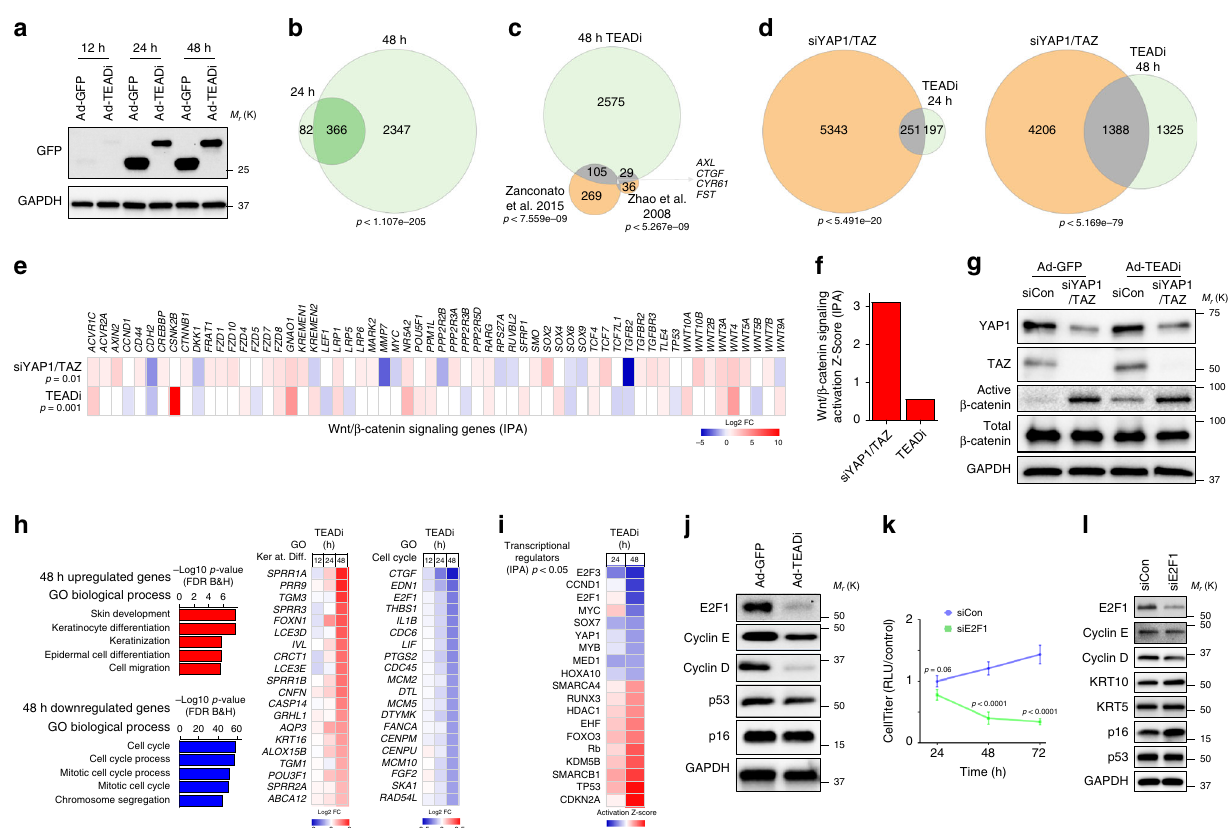
Fig. 2 TEAD transcriptional networks in keratinocytes regulate cell cycle entry and differentiation programs. a Western blot analysis of expression of GFP (Ad-GFP, control) and TEADi (Ad-TEADi) in N/TERT2G cells. b Venn diagram showing the overlap between differentially regulated genes in TEADi vs GFP ( q < 0.05, |FC| ≥ 1.5) in N/TERT2G keratinocytes at 24 and 48 h following transduction. c , d Venn diagrams showing the overlap between differentially regulated genes ( q < 0.05, |FC| ≥ 1.5) by TEADi expression in N/TERT2G keratinocytes and published YAP1 signatures 13,26 ( c ) or siYAP1/TAZ ( d ). e Graph indicating the fold change (Log2 FC) of genes related to canonical Wnt/ β -catenin signaling (IPA) in the siYAP1/TAZ and TEADi 48 h datasets. Only differentially regulated genes are shown. White color indicates the gene is not differentially regulated in that dataset. The IPA signi fi cance p -value ( p ) of overlap for the Wnt/ β -catenin canonical pathway is indicated for each dataset. f IPA activation Z-score for canonical Wnt/ β -catenin signaling in the indicated datasets. g Western blot analysis of expression of the indicated markers in N/TERT2G cells. Active β -Catenin refers to non-phospho β -Catenin at Ser45. h Graph indicating the GO biological process terms enriched in upregulated ( q < 0.05, FC ≥ 1.5) and downregulated ( q < 0.05, FC ≤ − 1.5) genes by TEADi expression in N/TERT2G keratinocytes at 48 h and fold change (Log2 FC) of genes related to GO keratinocyte differentiation and cell cycle at corresponding times compared with GFP expressing cells. i IPA functional analysis of activation state of upstream transcriptional regulators for genes in b . j Western blot analysis of the expression of cell cycle regulators in N/TERT2G cells transduced with GFP (Ad-GFP, control) or TEADi (Ad-TEADi) for 48 h. k Luminescence cell proliferation assay in N/TERT2G cells transduced with pooled siRNAs for E2F1. l Western blot analysis of the expression of cell cycle regulators and differentiation markers in N/TERT2G cells transduced with pooled siRNAs for E2F1 for 48 h. In k n = 3 biological replicates. Mean± SD is shown; two-way ANOVA with Sidak ’ s multiple comparison test. In b , c and d p indicates the p -value of the overlap in Venn diagrams, Fisher ’ s exact test. Source data are provided as a Source Data fi